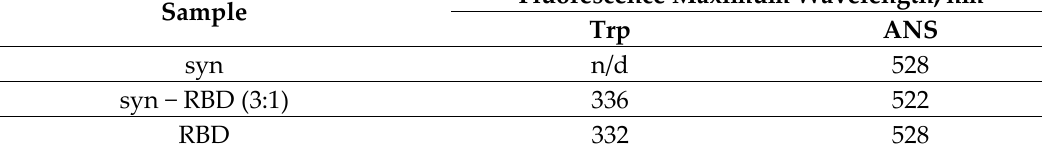
Figure 4. The structural change of the SARS-CoV-2 RBD observed in the presence of alpha-synuclein by Trp ( A ) and ANS ( B ) fluorescence. Trp ( A ) and ANS ( B ) fluorescence emission spectra of 5.6 μ M SARS-CoV-2 RBD (dot-dashed line), 28 μ M alpha-synuclein (solid line), 28 μ M alpha-synuclein mixed with 9.3 μ M SARS-CoV-2 RBD (molar ratio 3:1, dashed line). Please note that alpha-synuclein does not contain tryptophans (solid line).